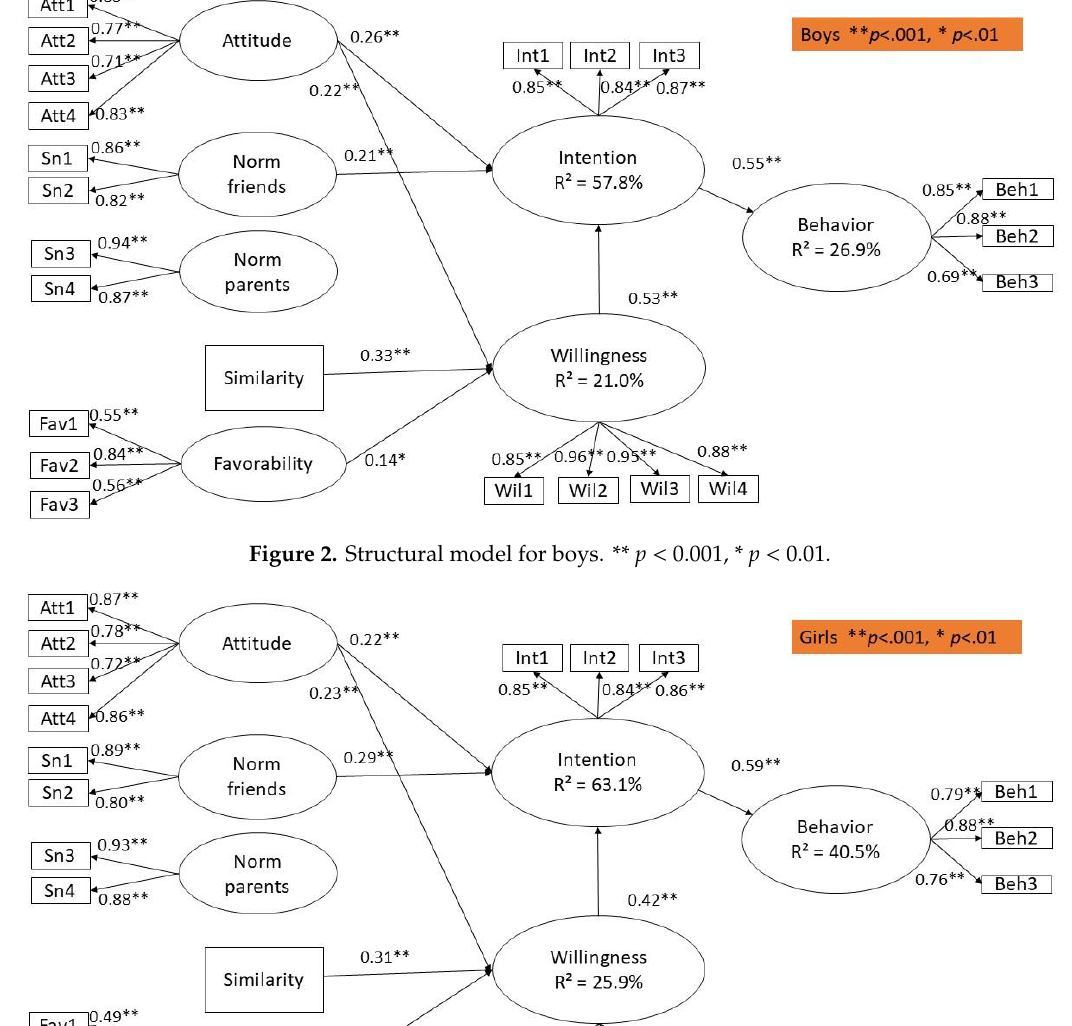
Figure 3. Structural model for girls. ** p < 0.001, * p <